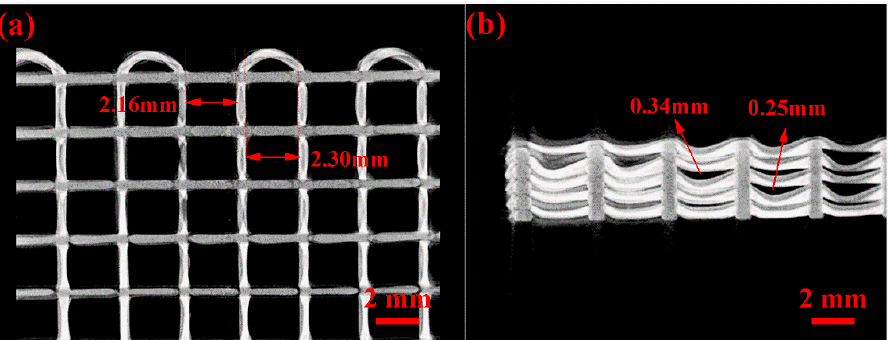
Figure 10. Computed tomography (CT) characterization images of silicone foams: ( a ) top view and ( b ) side view.